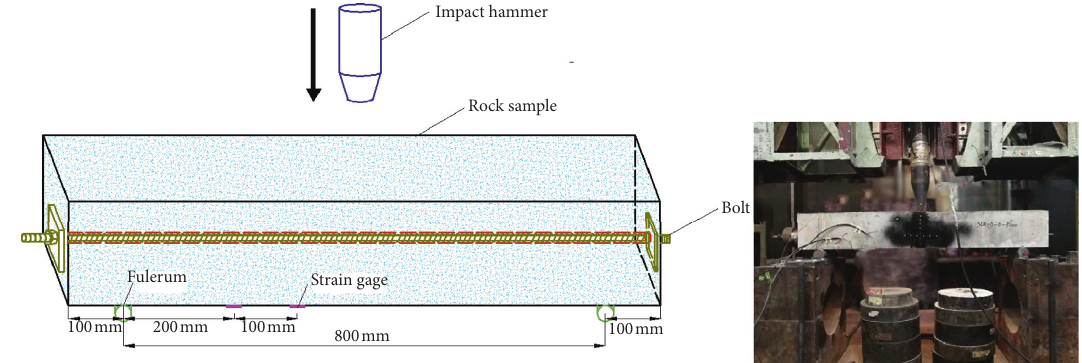
Figure 3: Schematic and physical drawings of the overall spatial arrangement of the